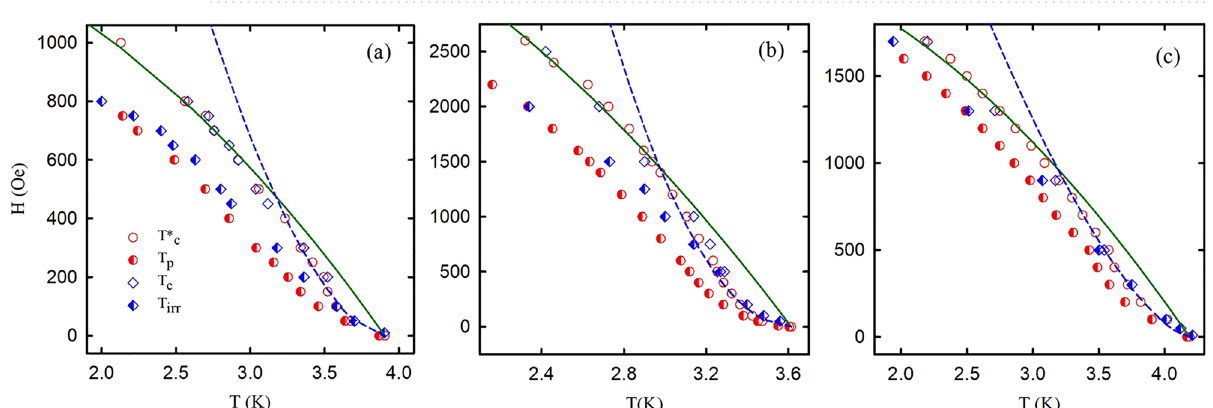
∗ T p , T c and T irr notations are defined in the text. The c ,